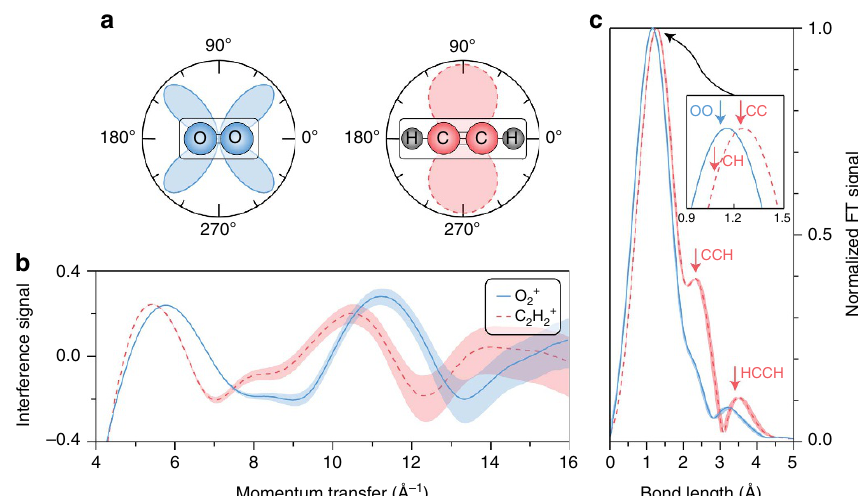
Figure 1 | Extracting bond lengths independent of HOMO structure. ( a ) Simulated ionization probabilities of the O 2 (blue solid curves throughout figure) and C 2 H 2 (red dashed curves throughout figure) HOMOs as a function of the angle between the molecular axes and the laser polarization direction. ( b ) The interference signals obtained for O 2 and C 2 H 2 after ionization of the molecules by the 3.1- m m source. In this panel the shading denotes that the error bars are estimated via Poissonian statistics. ( c ) The result of Fourier-transforming the interference signals. The expected positions of the O 2 and C 2 H 2 cation internuclear distances are indicated. The inset shows a zoomed-in view around 1.2Å, where a difference of about 0.14Å can be observed between the main peaks of the two molecules. The shaded regions represent the estimated error in the extracted spectra resulting from the uncertainty in the value of the ponderomotive